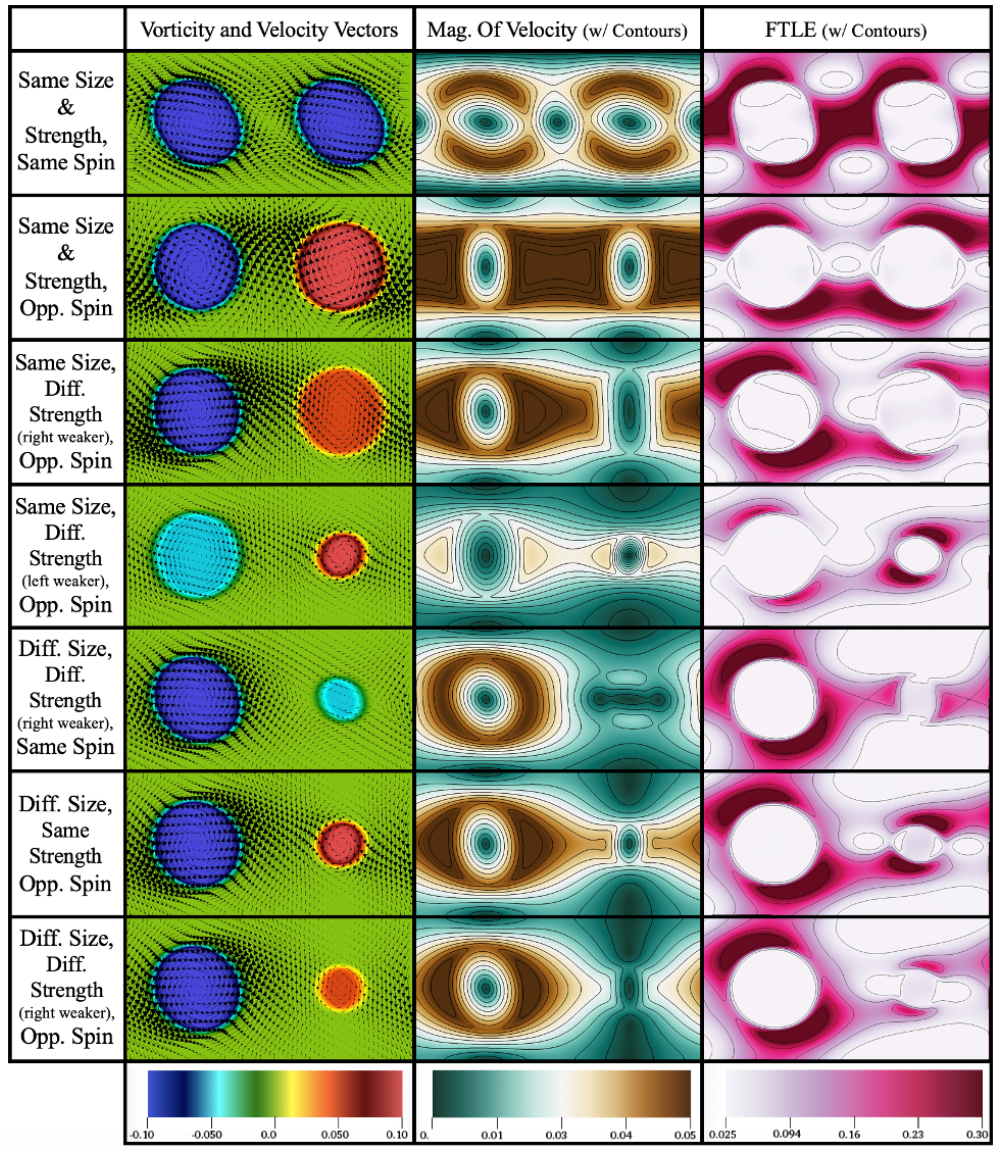
Figure 30. Vorticity and velocity field ( left column ) and magnitude of velocity with its associated contours ( right column ) for cases of two vorticity regions with different sizes, strengths, and vorticity